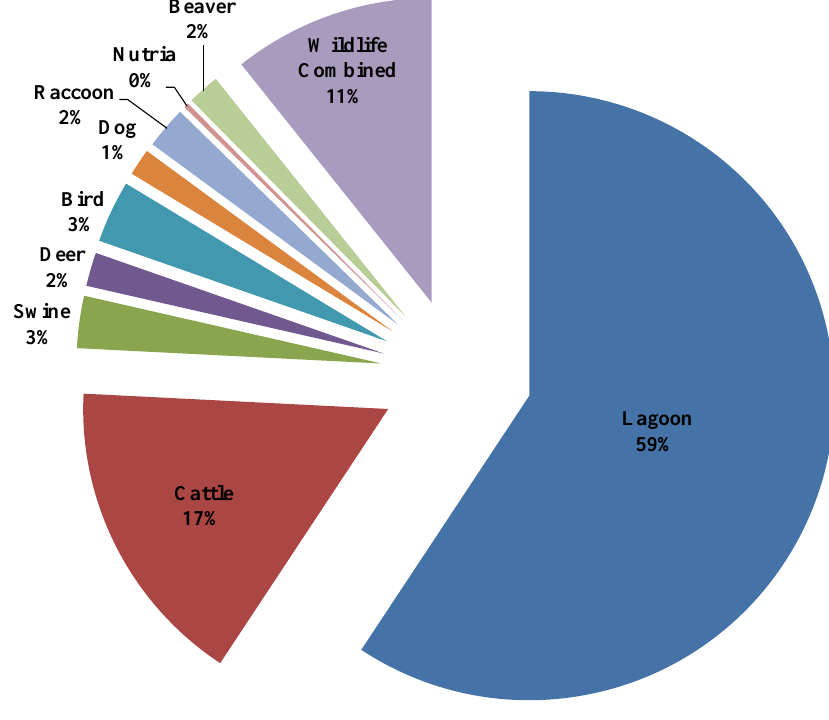
Figure 4. Host source identification of E. coli isolates (n = 1,715) from three Six Runs Creek sampling sites adjacent to waste application field two (WAF2).